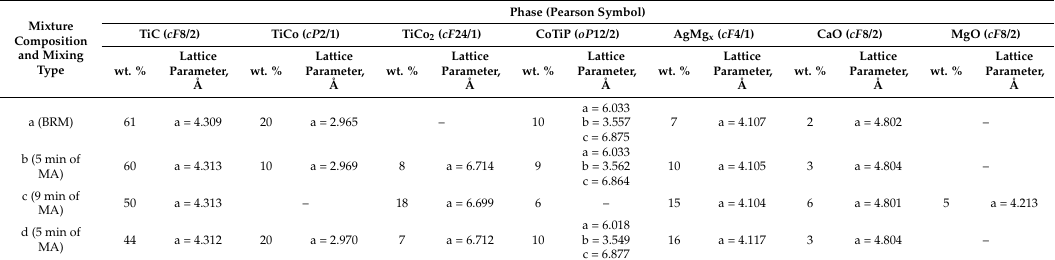
Table 3. Phase composition of the compact products of the